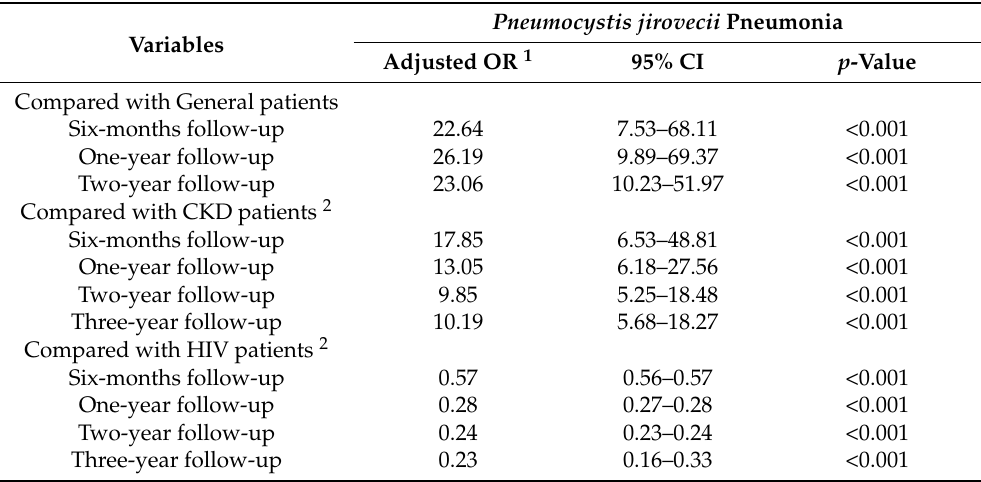
Table 3. Sensitivity analysis of incident Pneumocystis jirovecii pneumonia in the different observed periods. Pneumocystis jirovecii Pneumonia Variables p